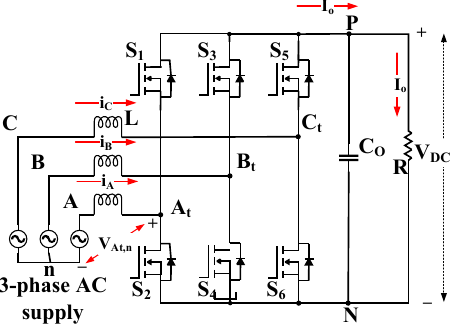
Figure 1. Simplified Circuit of Three Phase AC-DC Boost PFC Rectifier.